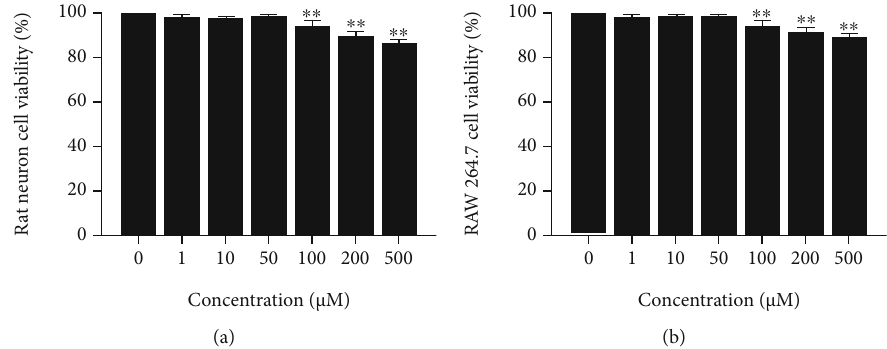
Figure 1: Representative MTT assay shows the viability of (a) primary spinal cord neurons and (b) RAW 264.7 cells incubated with metformin (0, 1, 10, 50, 100, 200, and 500 μ M) for 24h. ∗∗ P < 0 : 01 versus the control group, n = 5